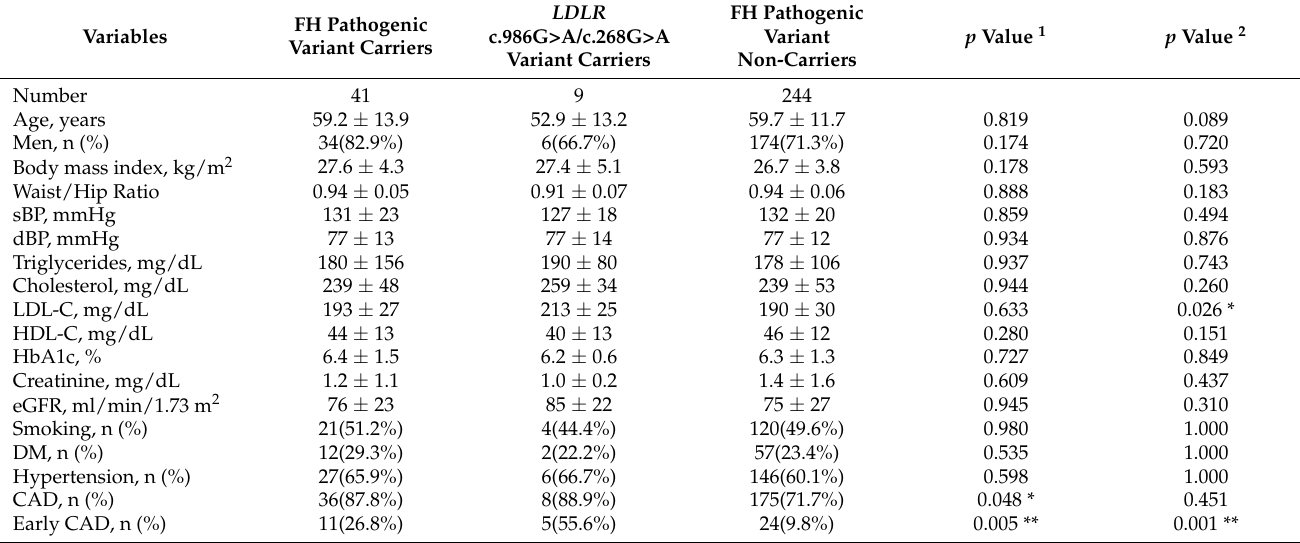
Table 1. Comparison of the clinical characteristics of FH pathogenic variant carriers, LDLR c.986G>A/ LDLR c.268G>A variant carriers † and FH pathogenic variant non-carriers in subjects with high blood LDL-C levels who underwent coronary